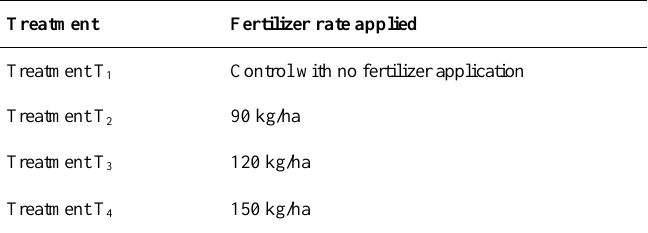
Table 1. Experimental